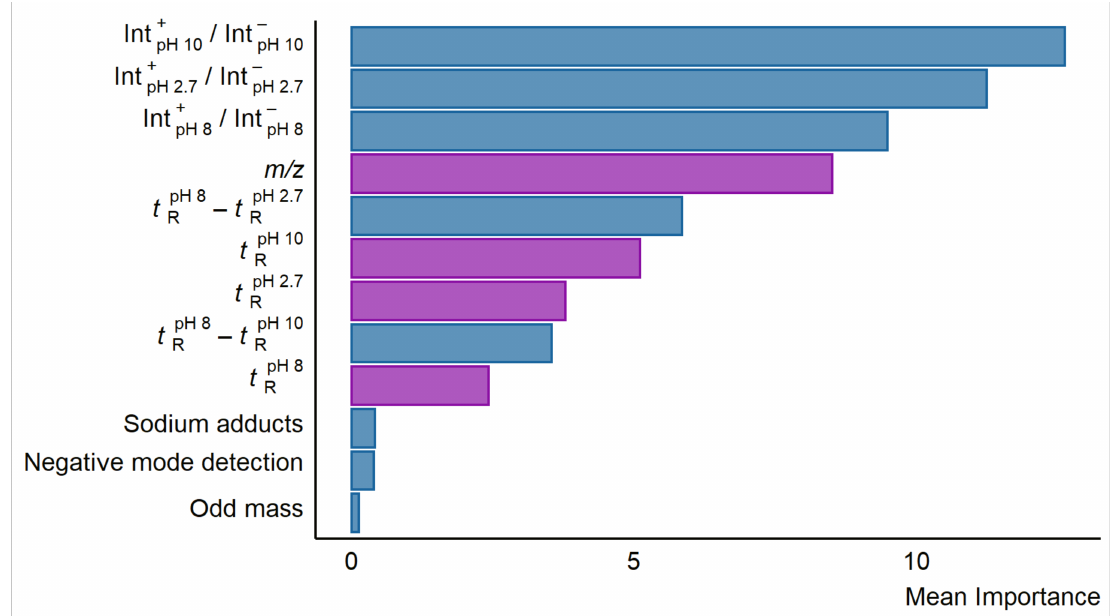
Figure 2. A bar plot showing the mean importance of the descriptors in the six developed random forest models using LC/MS features. The importance was calculated using the importance function from the RRF package in R. Descriptors correlated to log P are colored purple while descriptors in blue showed no significant correlation to neither log P nor p K a